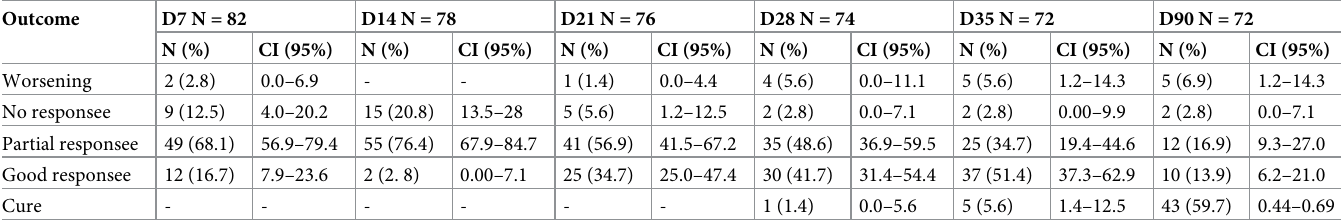
Table 3. IL SSG treatment outcomes among LCL patients on IL SSG treatment, Boru Meda General Hospital, 2021. Outcome D7 N = 82 Worsening Partial responsee Good